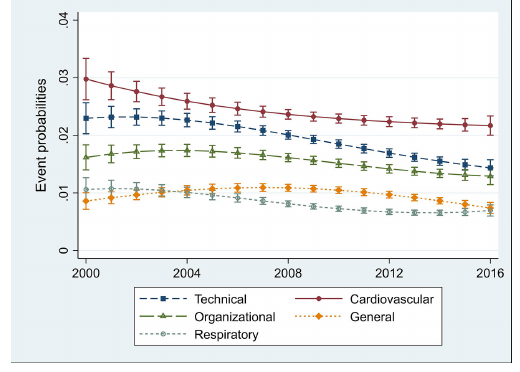
Figure 2: Marginal probability of specific IAE occurrence in ambu- latory anaesthesia between 2000 and